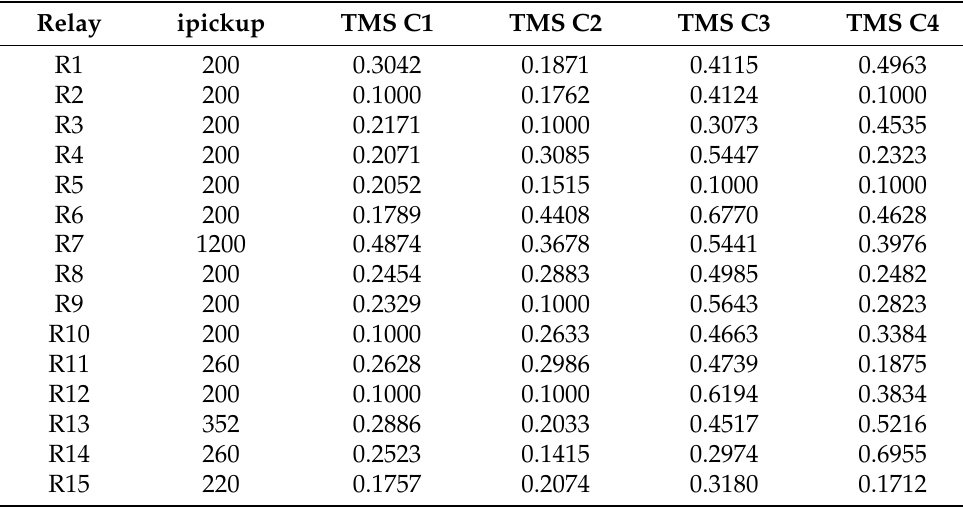
Table 9. Coordination adjustments with K-means via